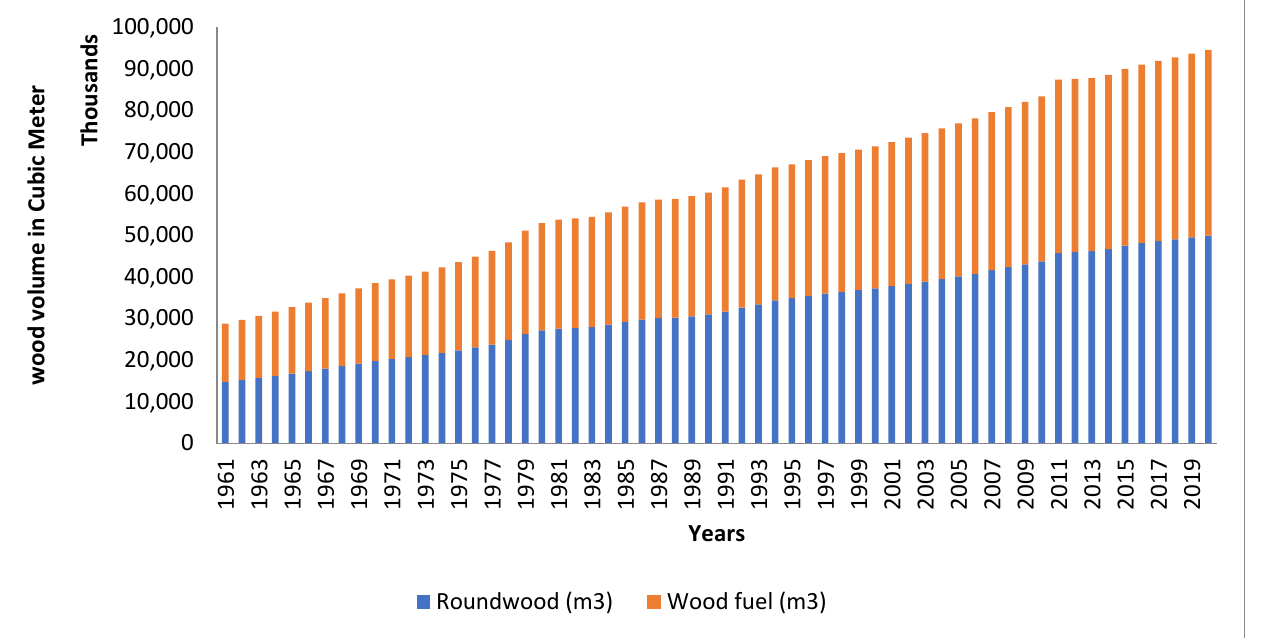
Figure 2. Total roundwood and total wood fuel production (1961 to 2020), own analysis. Uganda Revenue Authority, who collects taxes